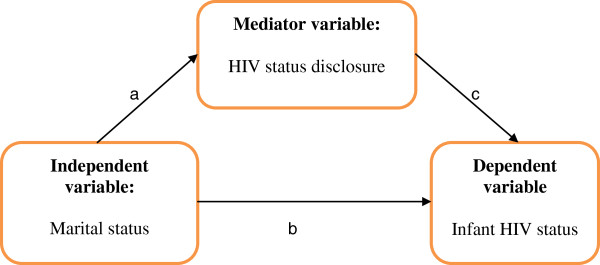
Path diagram for mediation effect of HIV status disclosure. Mothers and infants meeting inclusion criteria in the study. Muhima health centre cohort, Kigali/Rwanda, 2007-2010 [21]. The following steps were tested, as applied in social psychological research: first the independent variable affects the mediator in the first equation (a); second, the independent variable affects the dependent variable in the second equation (b); and third, the mediator affects the dependent variable in the third equation (c).